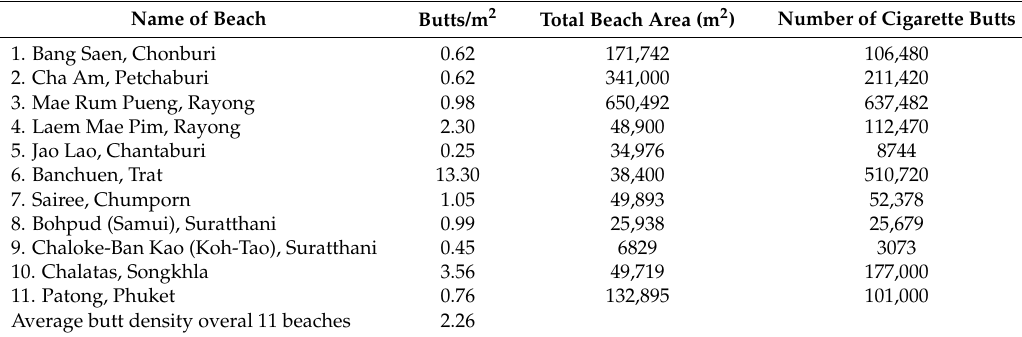
Table 2. Cigarette butt density estimated from sieved sand at 11 beaches along Thailand’s coastline,